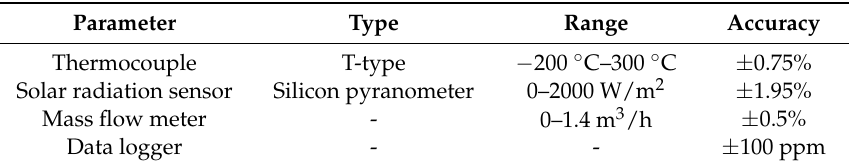
Table 2. Specifications of the solar collectors.